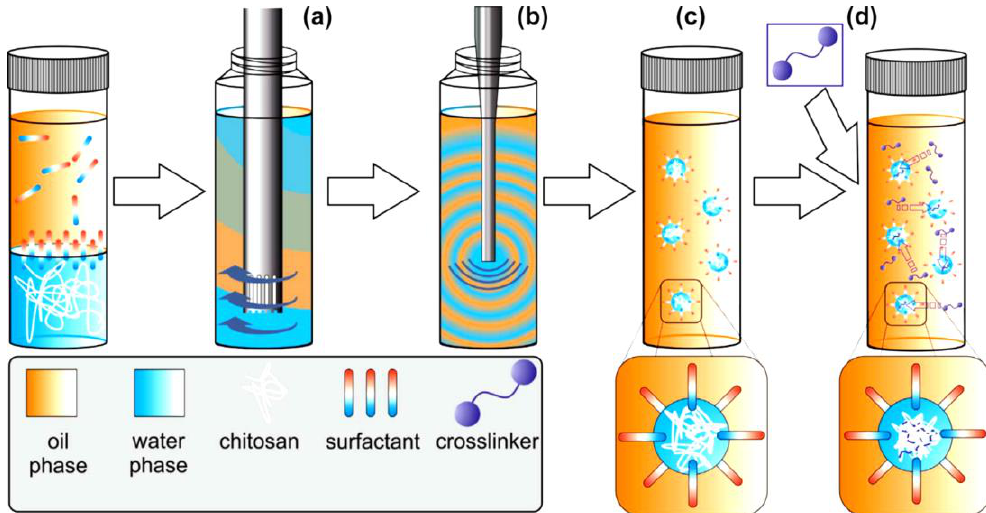
Figure 2. Schematical representation of emulsion crosslinking technique [14]. In a first step, the continuous phase was premixed with the disperse phase by rotor-stator treatment ( a ) followed by ultrasonication ( b ). To the resulting white and optically opaque emulsion ( c ) the crosslinker glut was added ( d ). To complete the crosslinking reaction, the emulsion was stirred for 18 h.